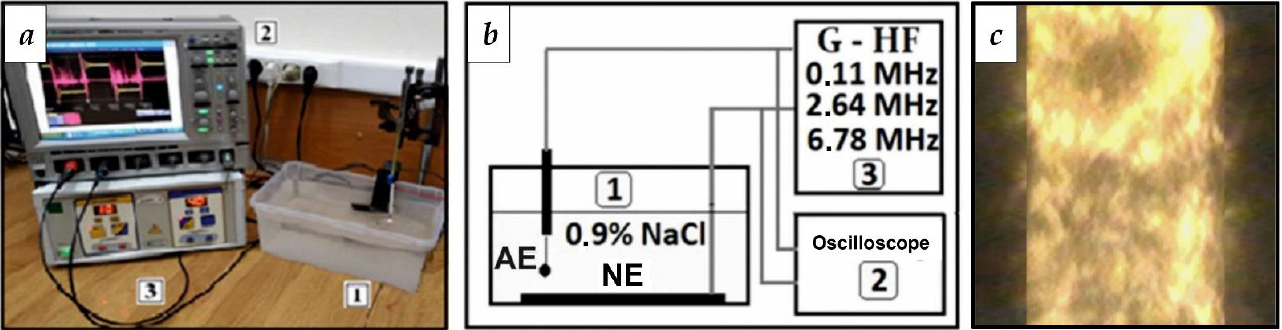
Figure 2. Stand for the study of LTP generation: ( a ) photo of the stand; ( b ) the main functional elements of the stand—a cell with an electrolyte solution (1), an oscilloscope (2), a high-frequency generator (G-HF) (3). Current and voltage oscillograms in the active electrode (AE)–electrolyte-neutral electrode (NE) circuit during the generation of LTP discharges were recorded using an electronic oscilloscope; ( c ) plasma photograph on the surface of a needle electrode with a diameter of 300 μm . Oscillograms of the curves of current (red curve) and voltage (yellow curve) for different LTP generation frequencies are shown in Figure 3.